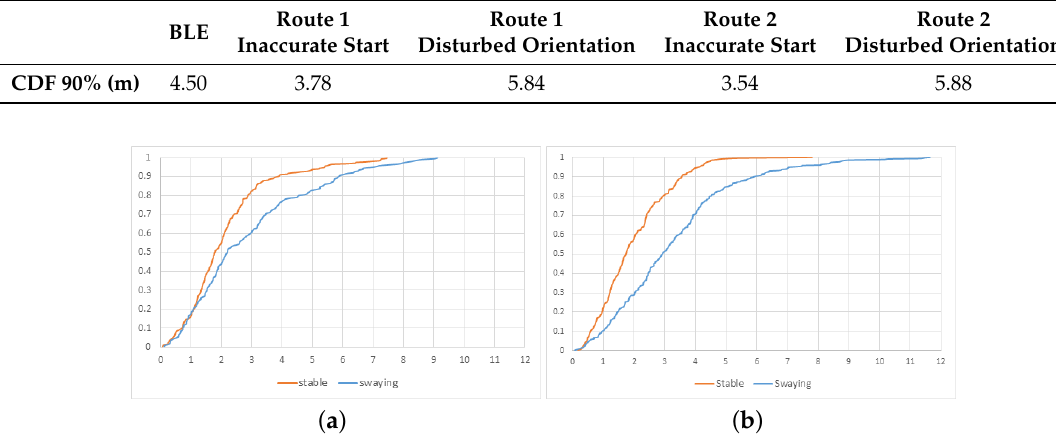
Figure 17. CDF of the both routes. Orange color indicates the case of inaccurate initial positions, while blue represents the case of disturbed orientations: ( a ) Route 1; and ( b ) Route 2.